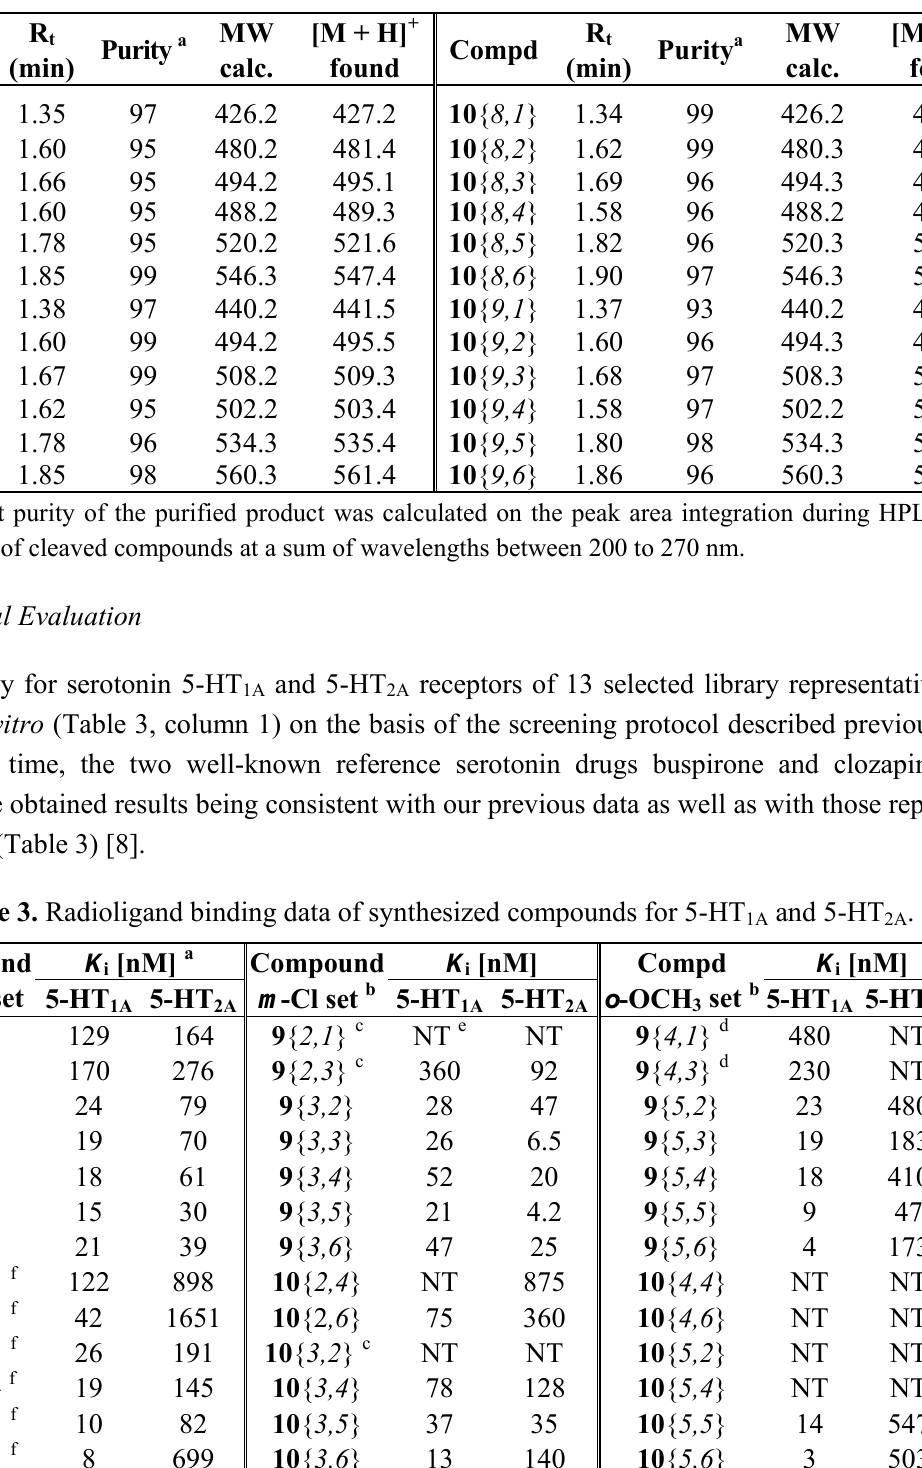
Table 2. Analytical data of the library.